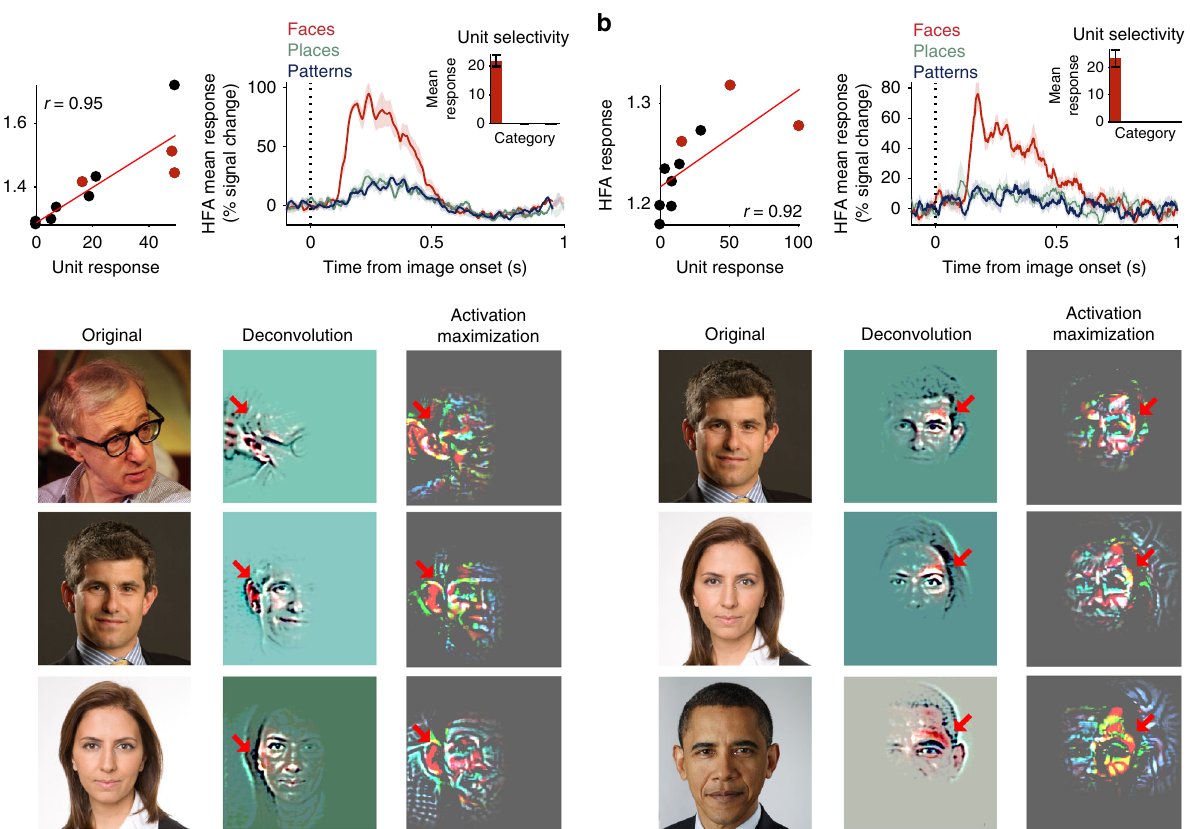
Fig. 4 Receptive fi eld reconstructions of two example model units. Two out of the seven model units that were found to signi fi cantly predict responses of single face contacts in a leave-one out search (see Supplementary Fig. 12 for the full set). Model units were de fi ned as units which were best correlated with a single iEEG contact responses to all N − 1 exemplar sets and signi fi cantly predicted the held out responses based on a linear fi t. a Model unit found in layer pool5 for set 1. Top left scatter plot depicts the responses of the model unit versus the mean HFA responses (50 – 500 ms) of the face contact. Red dots correspond to the three exemplars for which receptive fi eld visualizations are presented (see below). Red line is the least-squares linear fi t. Top right plot depicts the mean categorical responses of the face-selective contact to which the model unit matched. Bar inset presents the categorical selectivity of the model unit, which responded solely to faces and not to places or patterns. All error bars denote s.e.m. across exemplars. Bottom gallery presents visualizations of the model unit ’ s receptive fi eld for three example face exemplars: left column shows the original images in a descending order of the model unit ’ s response; middle column shows the reconstructed receptive fi eld using deconvolution; right column shows the delta between the altered image following activation maximization and the original image, re fl ecting the added image that maximally ampli fi ed the model unit ’ s response. For visualization purpose, the contrast of each receptive fi eld image was normalized by stretching the active range of RGB values. b Same as panel a , depicting a different model unit detected in layer pool5 for set 1 and its matching face contact. Note the view point selectivity and consistency of the face fragments that are highlighted by the two visualization procedures, and the large expanse of image changes following activation maximization. Copy rights